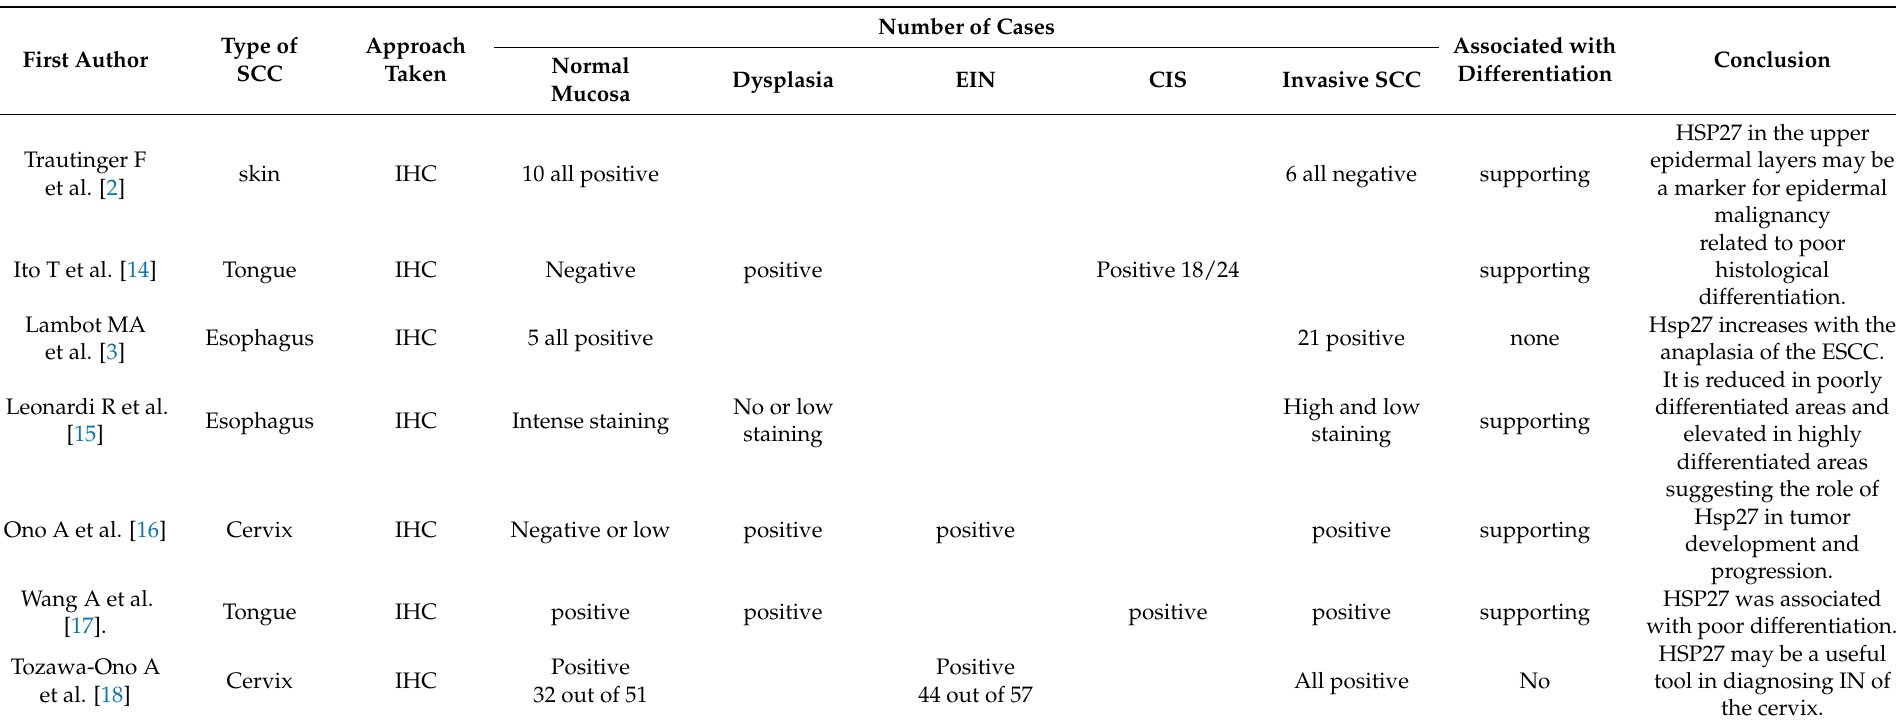
Table 1. Expression patterns of HSP27 in